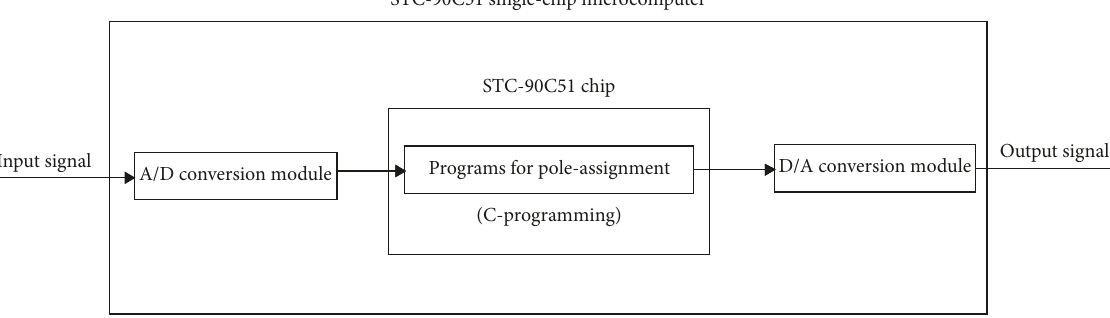
Figure 7: The flow chart for realizing the pole assignment of the system.